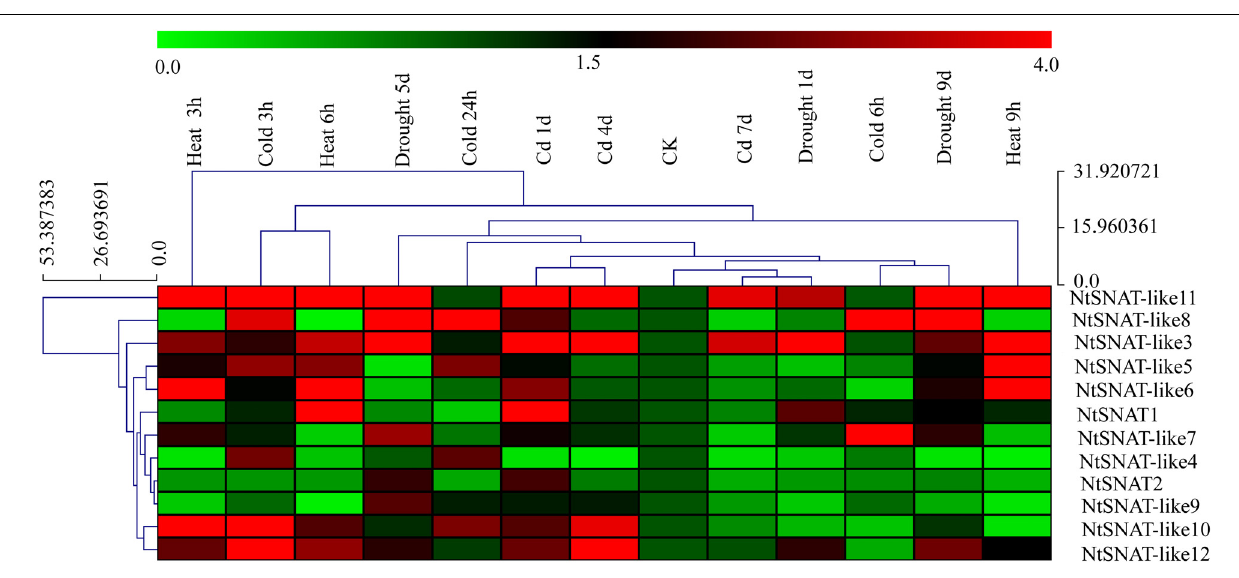
Frontiers in Genetics |